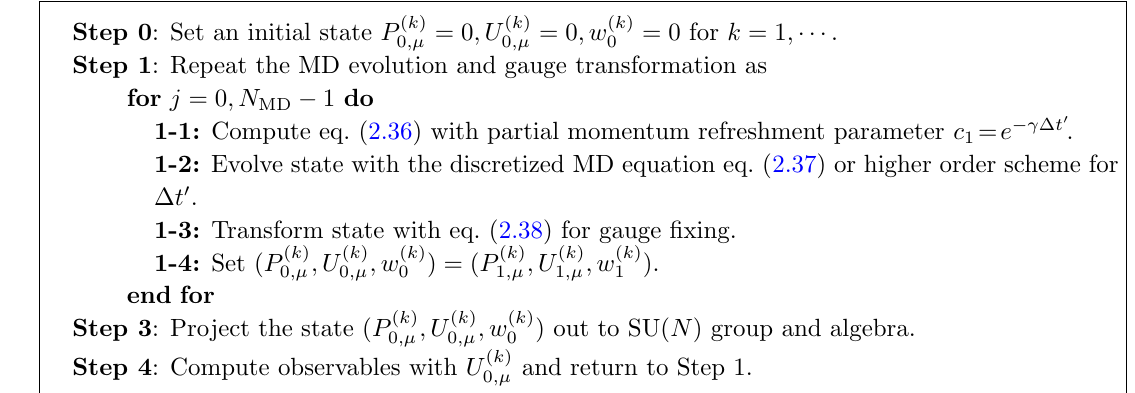
Algorithm 2. NSPT algorithm based on GHMD. The MD time step size (cid:1) t 0 = 1 =N MD ,